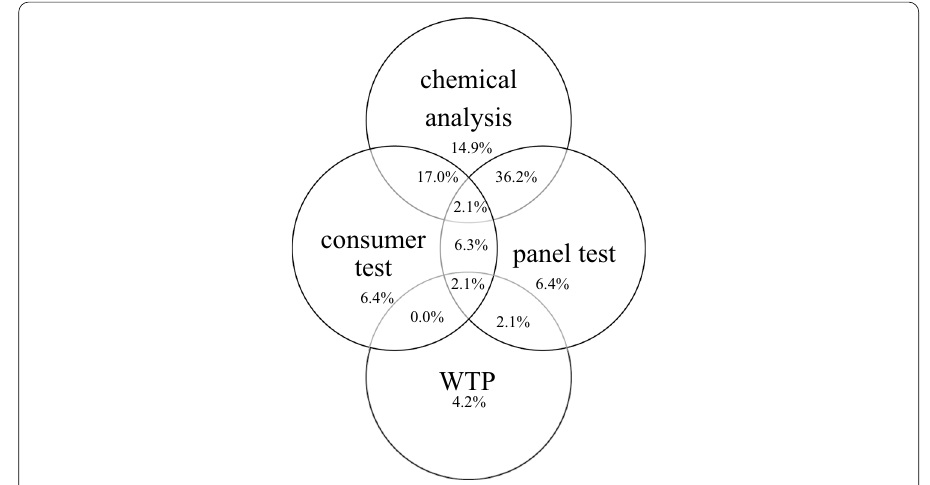
Fig. 6 Research topics of articles included in the review